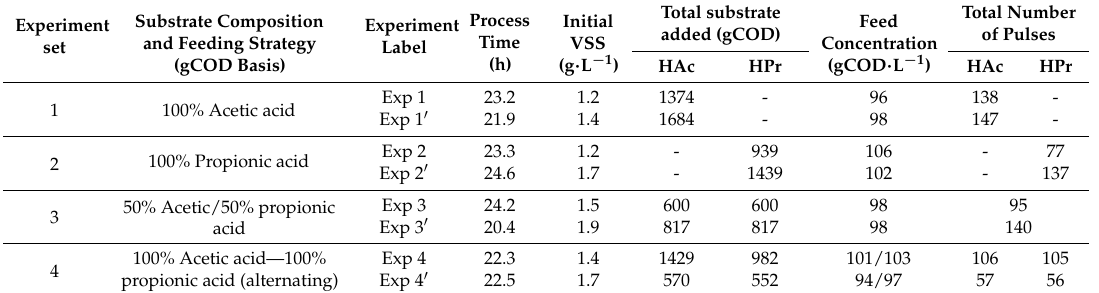
Table 1. Experimental conditions in the PHA (Polyhydroxyalkanoates) fed-batch accumulations. Process Substrate Composition Experiment Experiment and Feeding Strategy Label set (gCOD Basis)